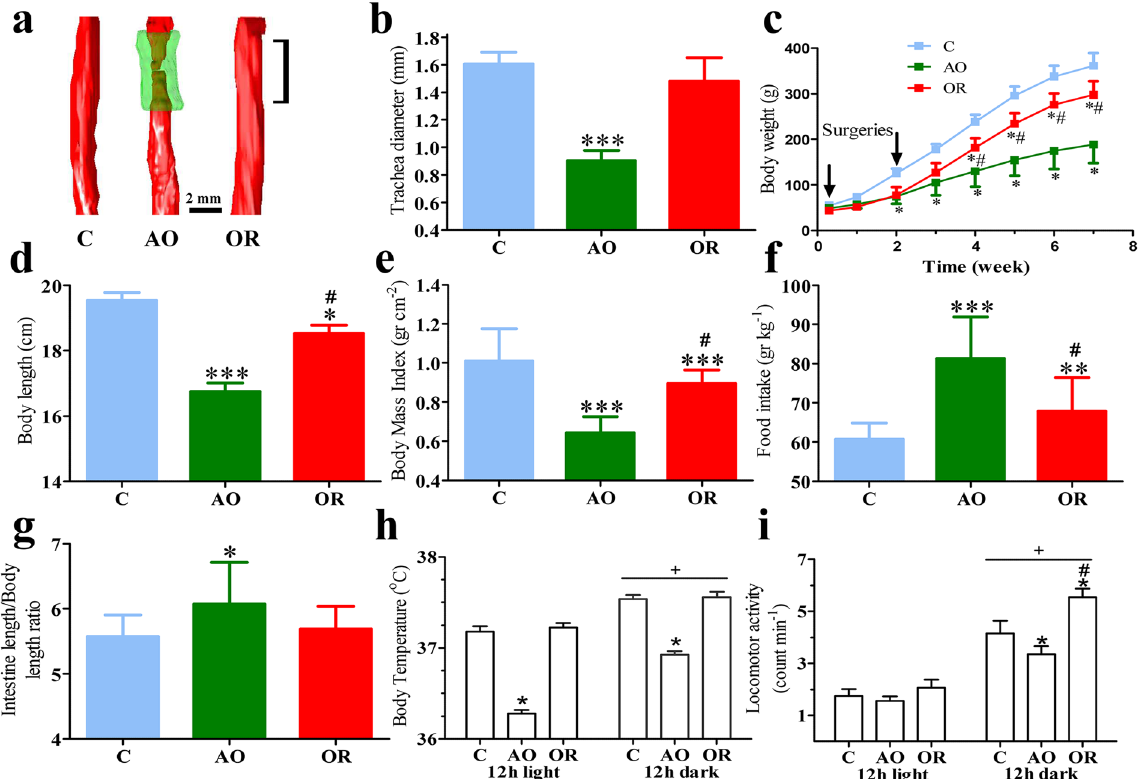
Figure 2. Body weight and daily food intake. Effect obstruction (AO) and obstruction removal (OR) on ( a ) Trachea 3D magnetic resonance imaging (symbol on OR image indicates the location of obstruction); ( b ) Trachea diameter; ( c ) Body weight curve over the duration of the observation period; ( d ) Body length; ( e ) Body mass index; ( f ) Daily food intake; ( g ) Intestinal length to body length ratio; ( h ) 12-hour average lights on and lights off body temperature and locomotion activity ( i ). Error bars in ( b , d , h , i ) are s.e.m; error bars in ( c , e , f , g ) are s.d. * p < 0.05, ** p < 0.01, *** p < 0.001 difference between control group (C, blue color) and AO group (green color). # p < 0.05 difference between AO and OR (red color). In ( b ), d–i statistical differences were determined by unpaired 2-tailed t test; In ( c ) statistical difference between groups were determined by two-way ANOVA followed by Student-Newman-Keuls